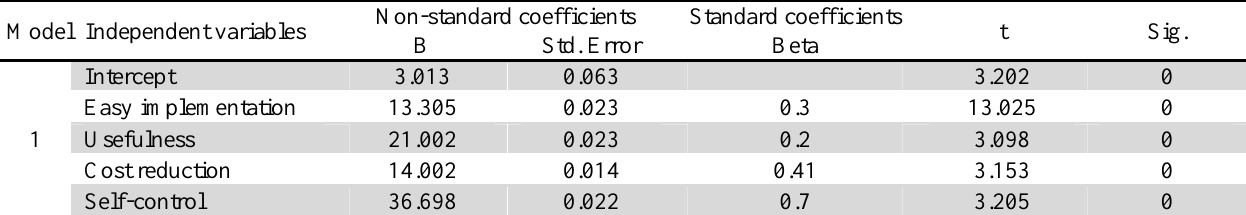
The summary of regression analysis Model Independent